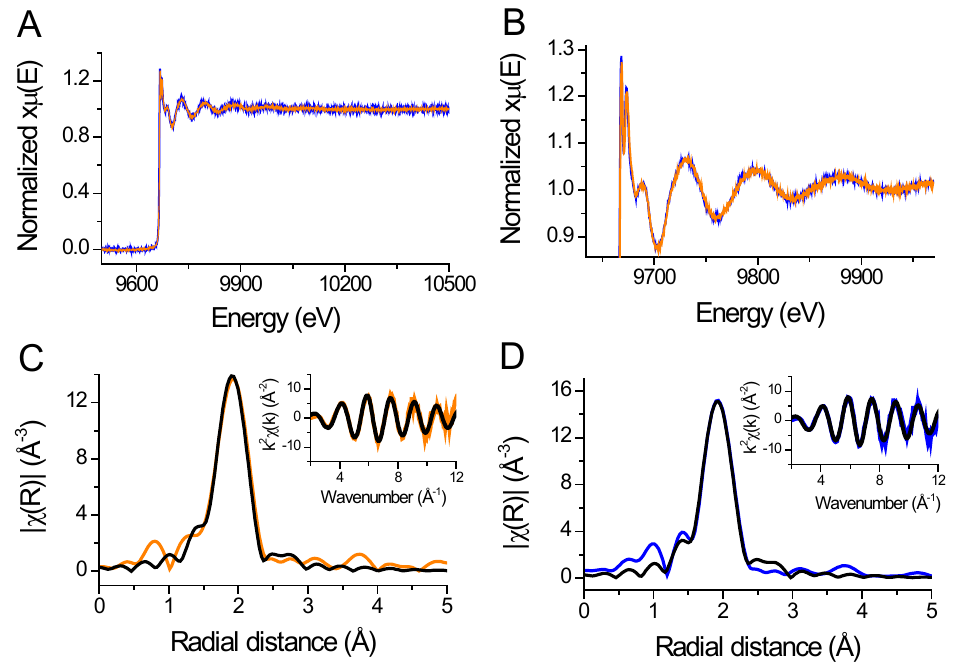
Figure 8. ( A ) Full X-ray absorption spectra of Hs Hk183 (orange line) and Hs Hk183 T690E (blue line) represented as normalized absorption coefficient plotted versus energy. ( B ) Zoomed in near edge region and extended absorption spectra. ( C , D ) Fourier-transformed and k 2 -weighted (insert) data for Zn( Hs Hk183) 2 and Zn( Hs Hk183 T690E) 2 , respectively. The black line represents the fit to the data.